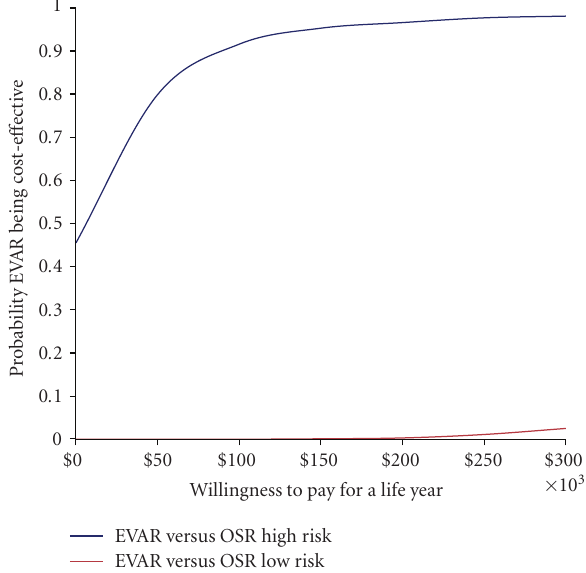
Figure 5: Cost-e ff ectiveness acceptability curves